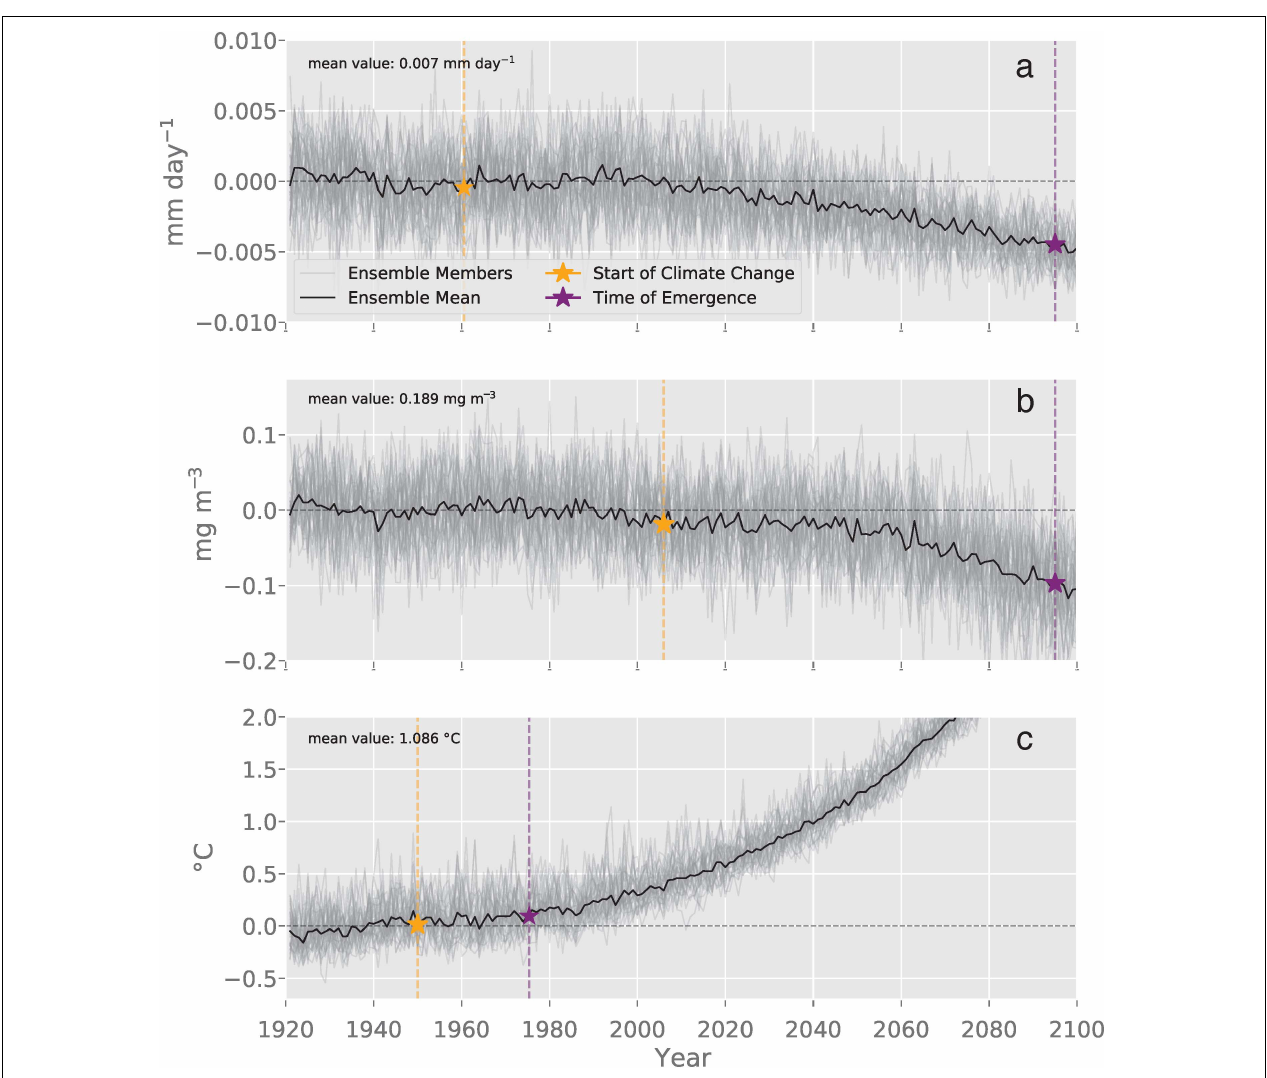
FIGURE 4 | This plot of the spatially averaged modeled DJF fields for the Southern Ocean illustrates the temporal evolution of (a) krill growth potential anomaly (mm day − 1 ), (b) surface chlorophyll (mg m 3 ), and (c) sea surface temperature ( ◦ C). Each ensemble member anomaly is plotted in gray while the black line is the mean ensemble anomaly. The means for each variable are listed in the upper left corner of each plot. The yellow stars indicate the year when the climate change signal was detected (Climate Change Year; GP: 1960, Chl: 2006, SST: 1950). The purple stars indicate the year of detection where trends forced by human-driven climate change can be formally distinguished from natural variability (Year of Detection; GP: 2095, Chl: 2095, SST: 1975) (Eq.